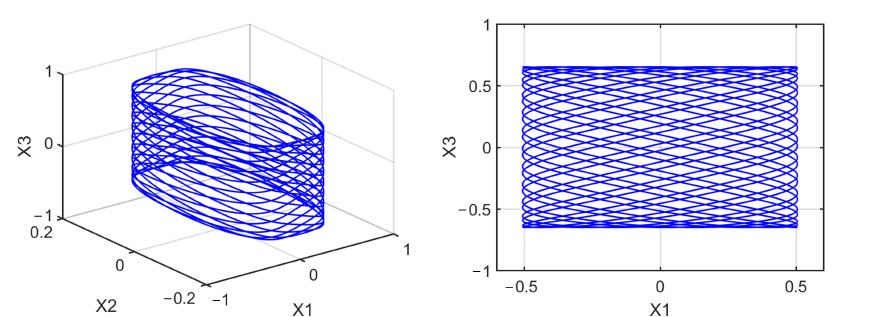
Figure A25. Periodic-22 motion of σ 1 = 6.8000.